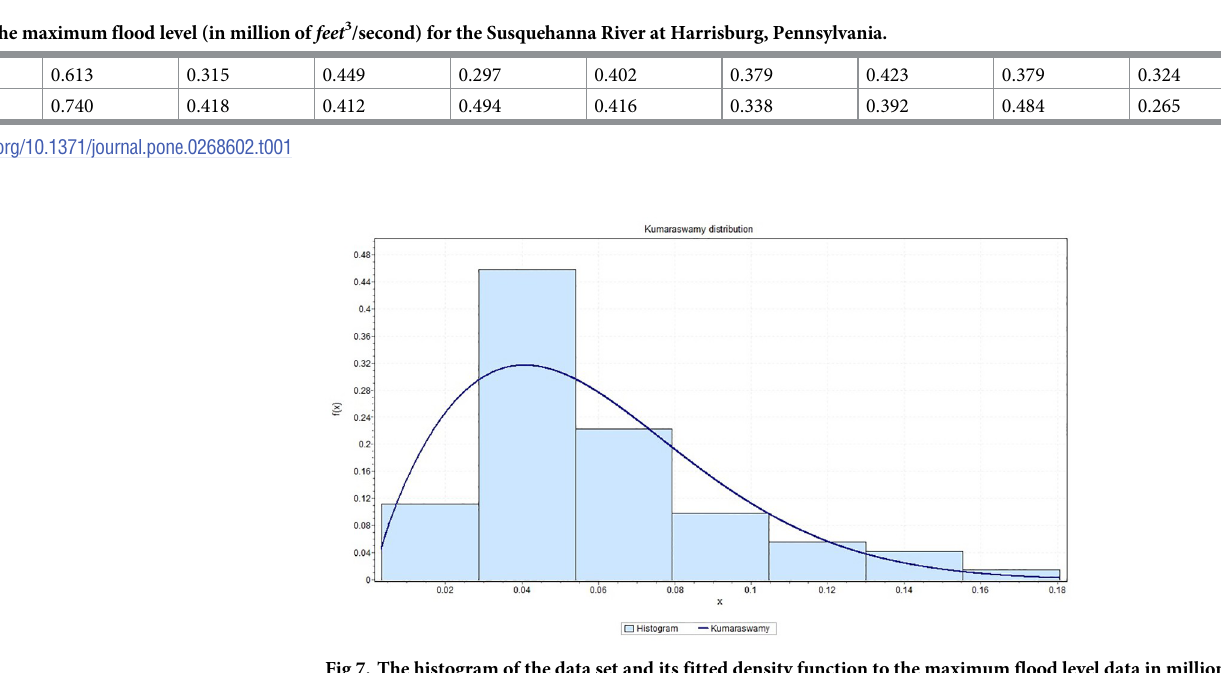
Fig 7. The histogram of the data set and its fitted density function to the maximum flood level data in million of feet 3 /second.